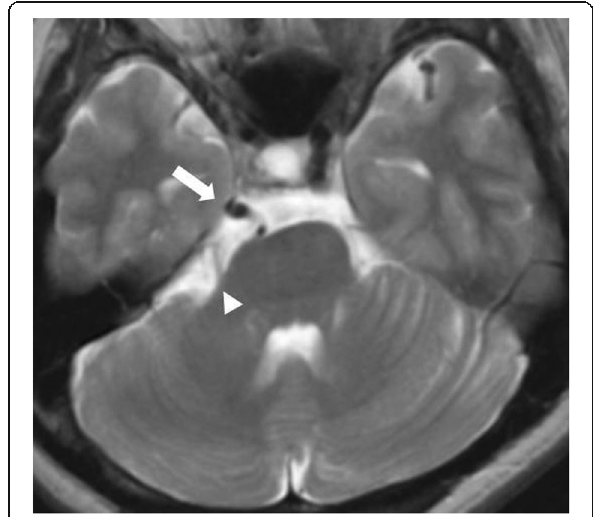
Fig. 1 Magnetic resonance imaging. Axial T2-weighted magnetic resonance imaging showing the right primitive trigeminal artery, a flow void (arrow) coursing postero-laterally between the dorsum sella and the cisternal portion of the trigeminal nerve (arrowhead)